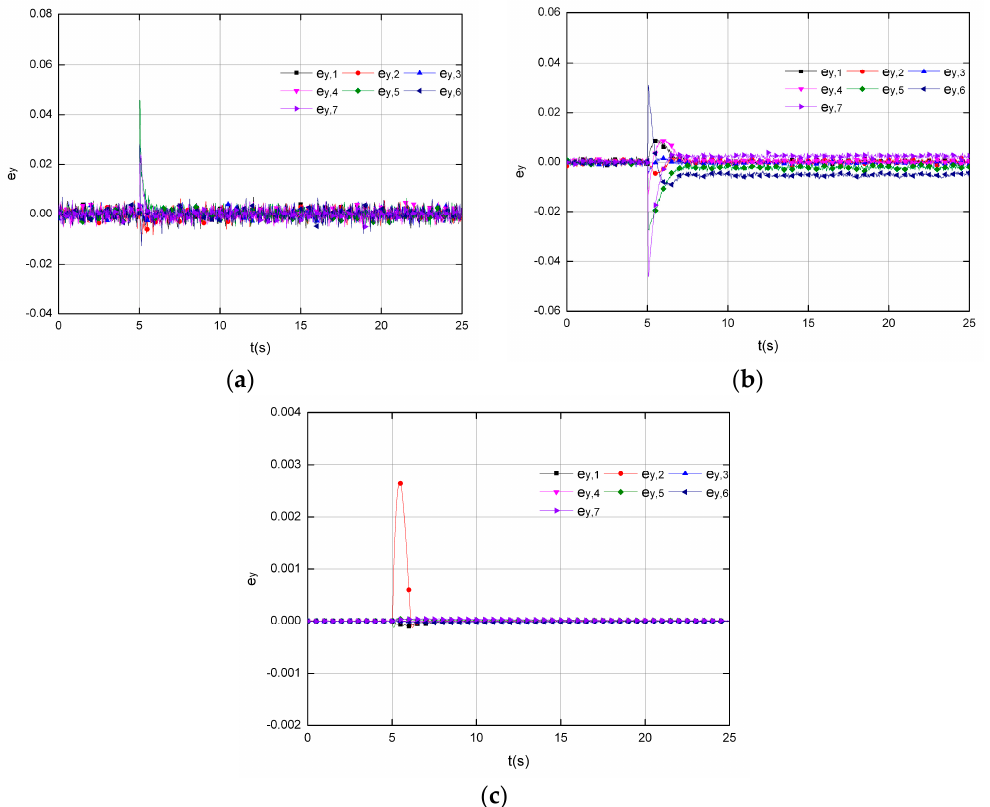
Figure 8. The output errors corresponding to the injected 6% decrease on h 2 , 2% decrease on h 4 and 2% increase on h 7 , that is applied at t = 5 s (Mode 5) in scenarios with uncertainties. ( a ) Results by KF; ( b ) Results SMO; ( c ) Results by SOSMO.